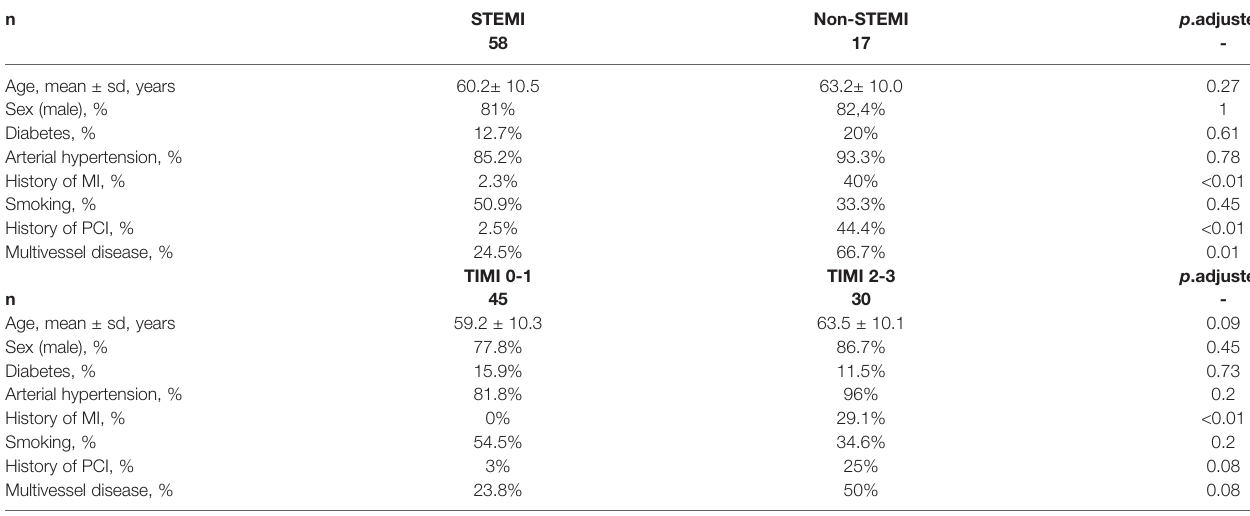
TABLE 1 | Comparison of clinical data of patients in different groups, two types of strati fi cation (STEMI vs. Non-STEMI; TIMI 0-1 vs. TIMI 2-3).